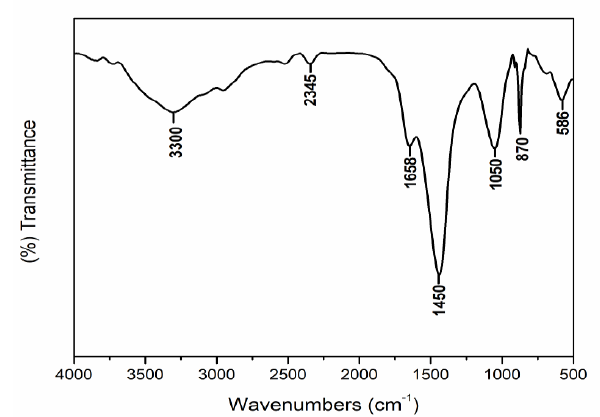
Figure 5. FTIR analysis of formulated organic fertilizer